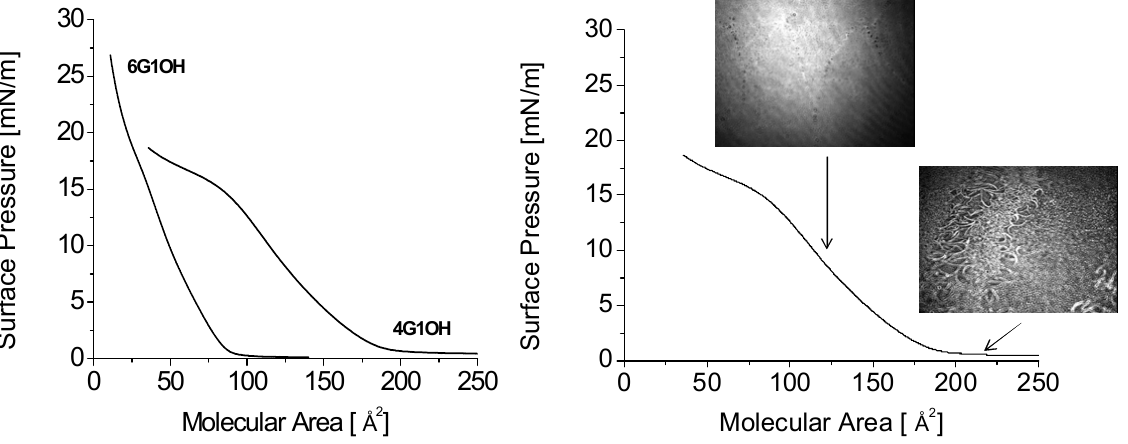
OH and 6G OH with BAM images. 1 1